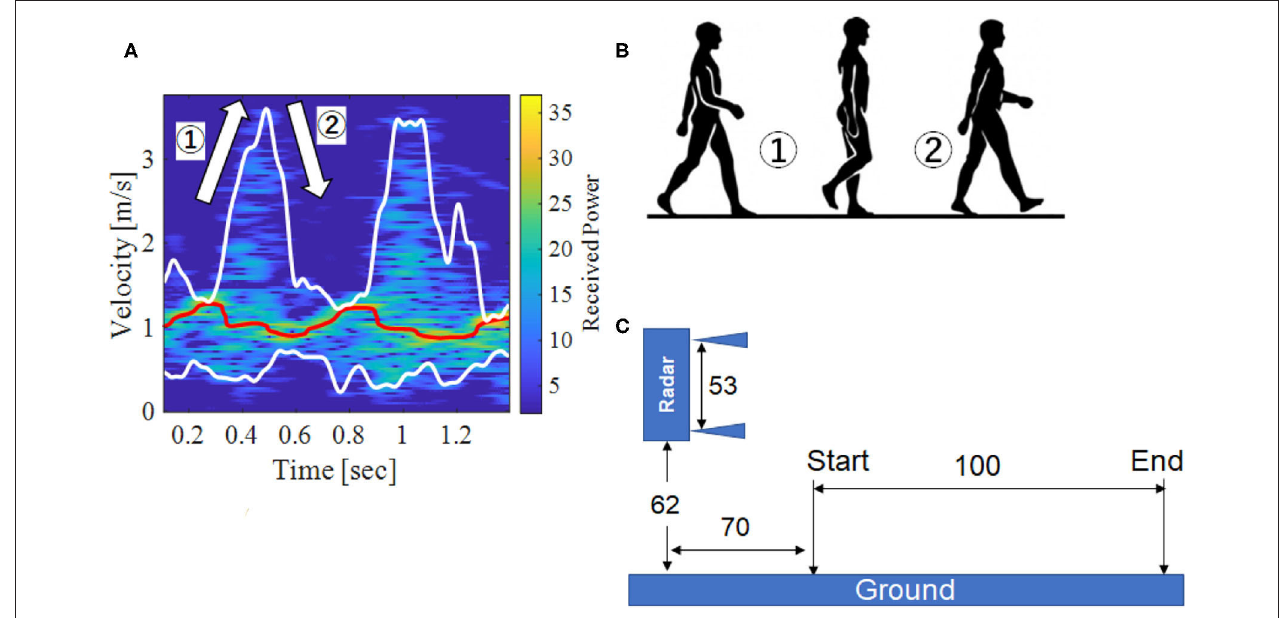
FIGURE 1 | Doppler radar image and experimental environment. (A) Original image, (B) Walk process, (C) Experimental